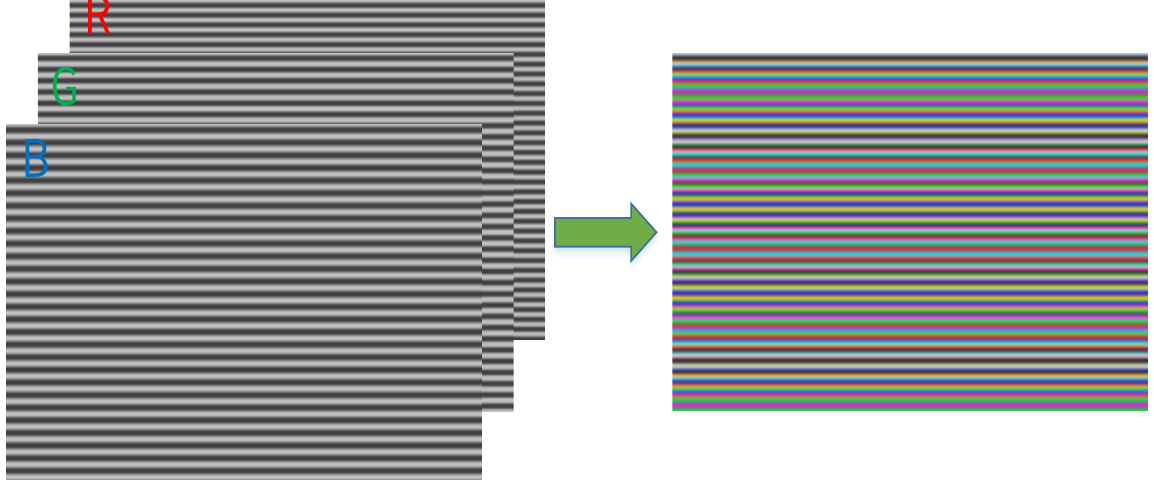
Figure 5. Composition of color-encoded fringe pattern.